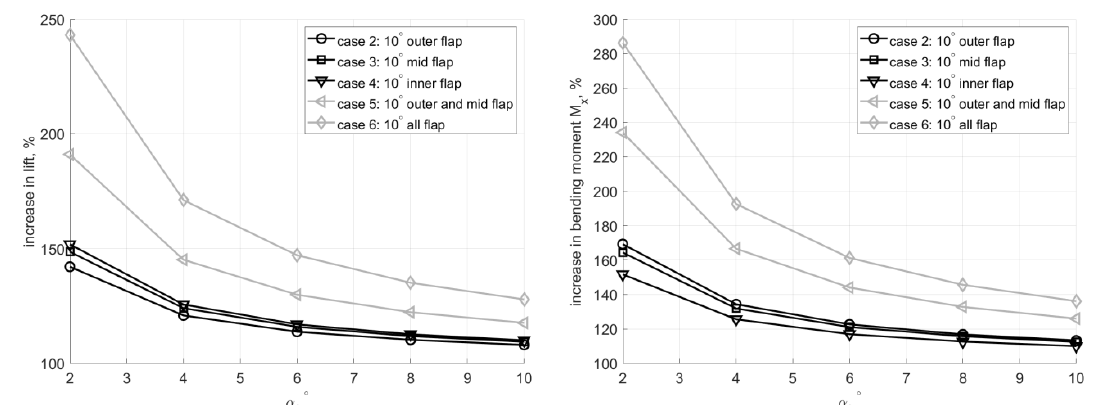
Figure 5. Relative increase of lift and root bending moment for various angles of attack (independent of flight velocity), and various flap deflection cases.